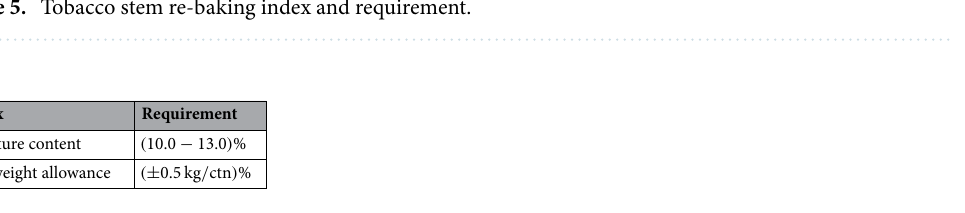
Table 6. Tobacco stems packing index and requirement.